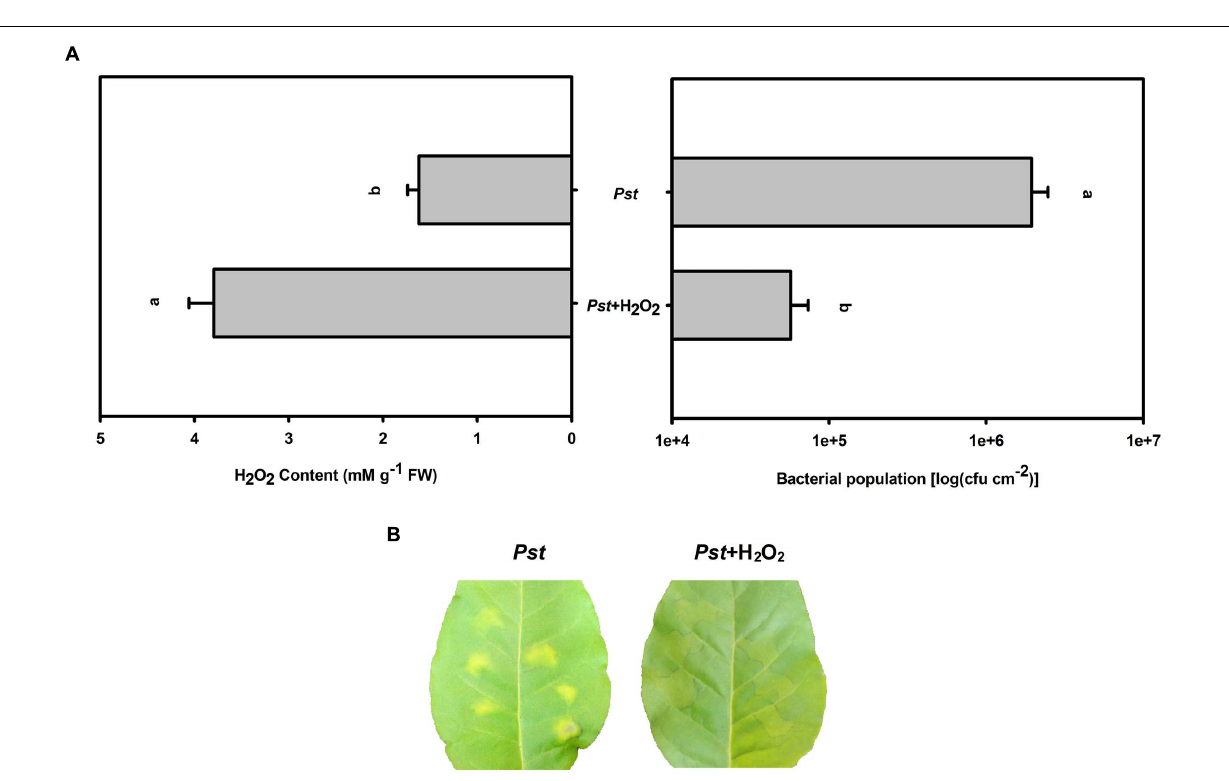
Frontiers in Plant Science |